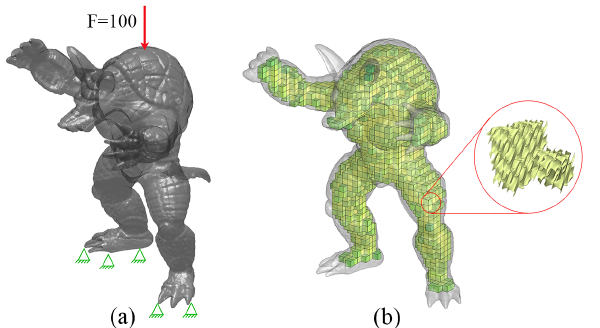
Figure 16. Armadillo model: ( a ) boundary condition and loading, ( b ) optimization result using orthotropic ( F 3 ) cellular materials.